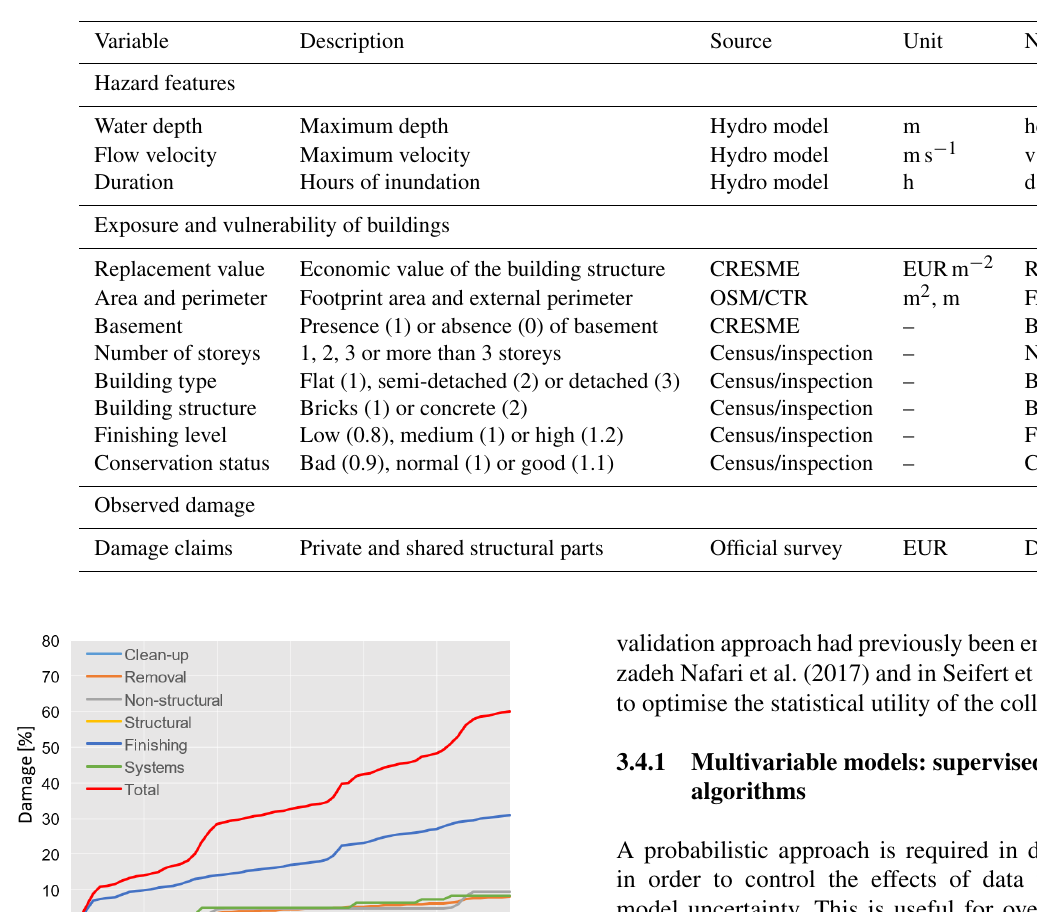
Table 1. List of variables included in the multivariable analysis.